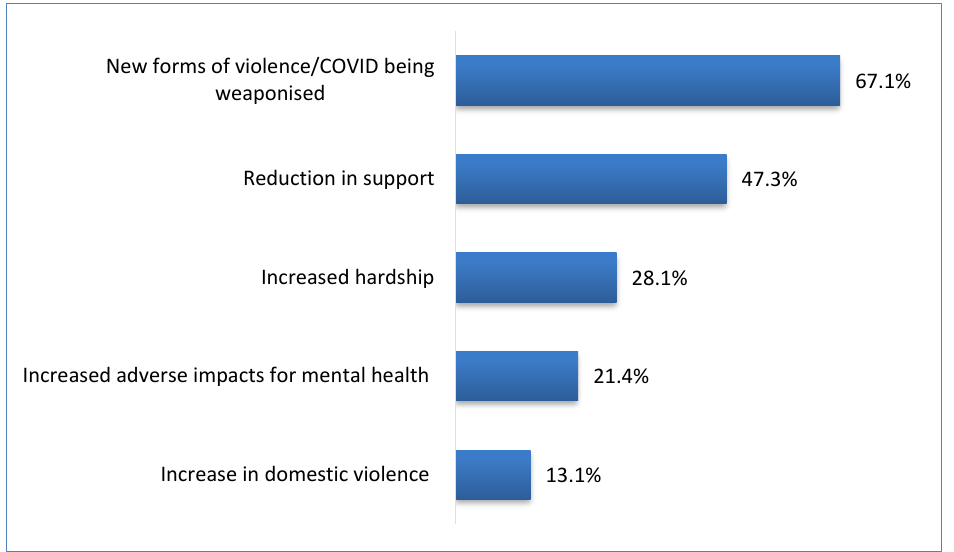
Figure 3. Overarching themes of